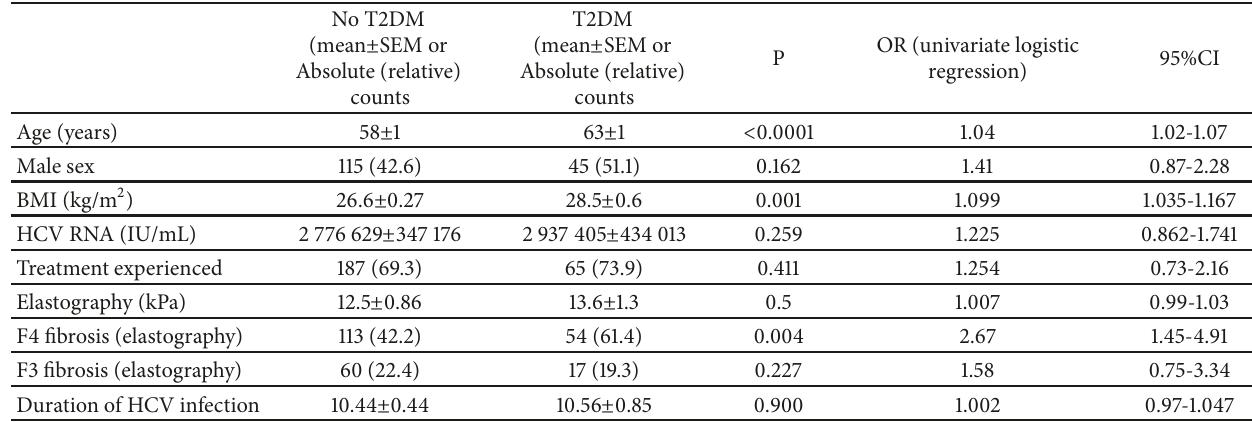
Table 5: Association of type 2 diabetes mellitus with various predictors.